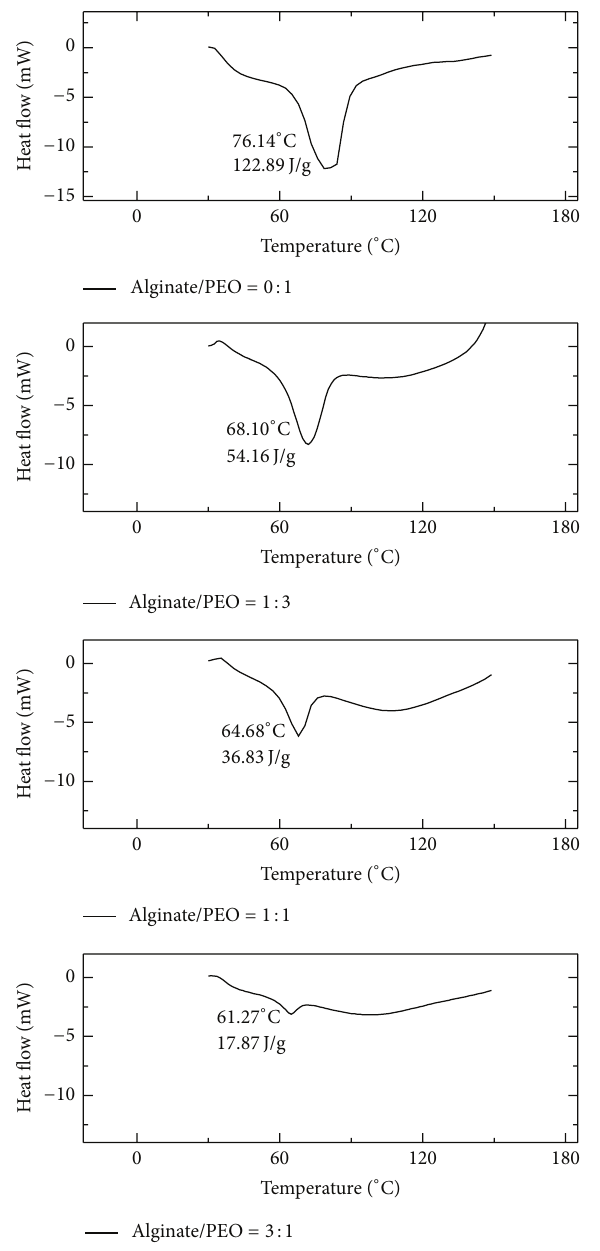
Figure 8: DSC patterns of electrospun nanofibers from 5% solution concentration with different NaAlg/PEO ratios.